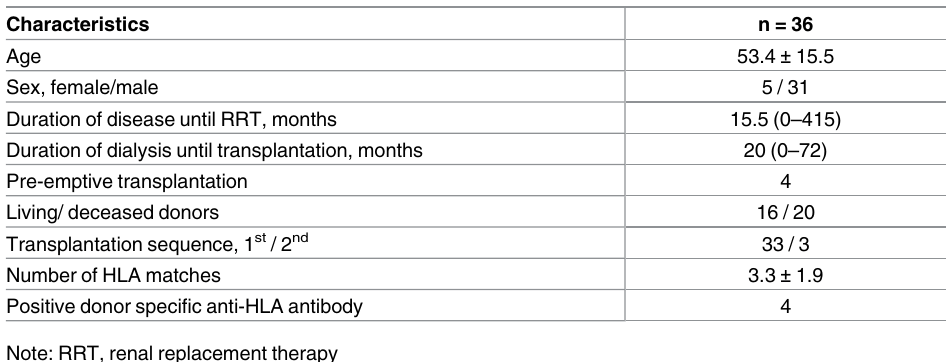
Table 1. Patient characteristics.